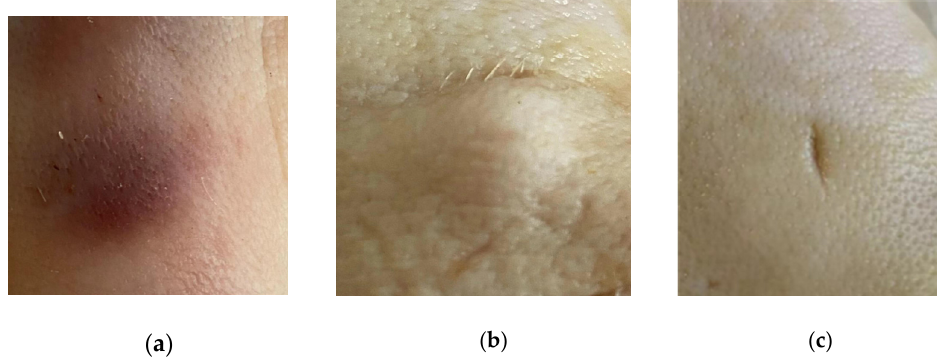
Figure 19. Different abnormal skin abnormalities: ( a ) bruise; ( b ) nodules; ( c ) wound.